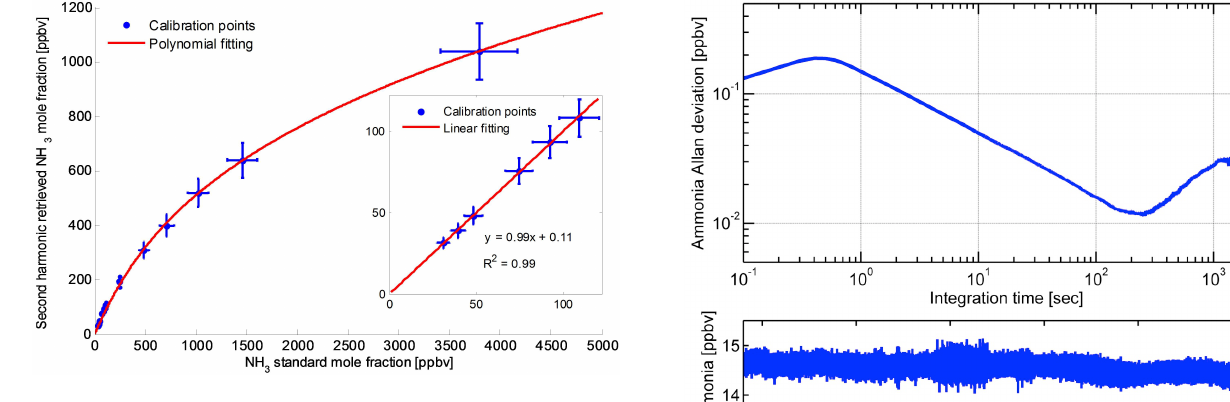
Fig. 4. Calibration curve derived from direct absorption measure- ments for various NH 3 gas standard mole fractions at atmospheric pressure. Inset: linear fitting of calibration curve for mole frac- tions below 120ppbv NH 3 . Error bars for each calibration point are ± 10% for each measurement method (direct absorption and 2f retrieval).